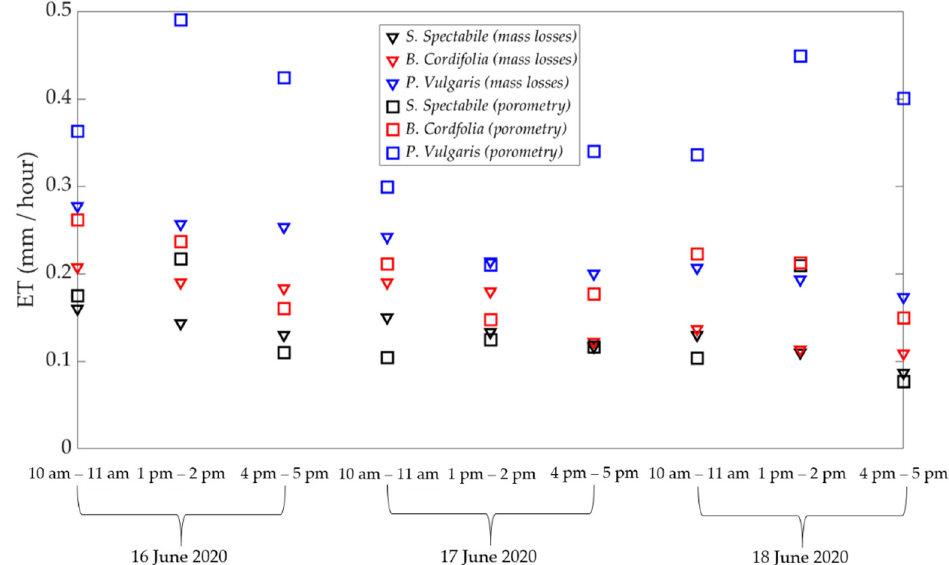
Figure 6. ET rates found via porometry and the mass loss method for the S. spectabile , B. cordfolia and P. vulgaris species. Data shown are between 16–18 June.